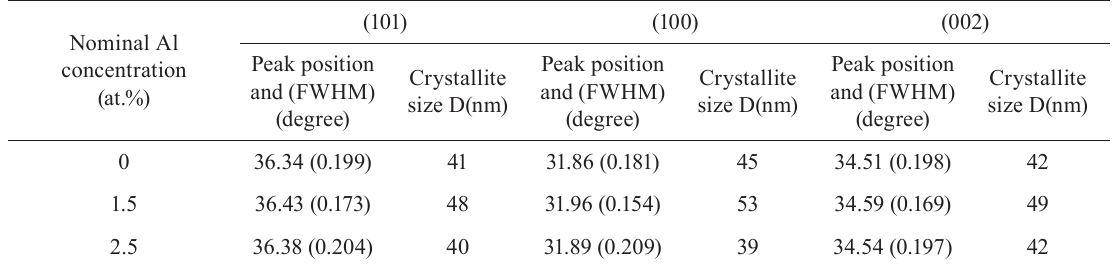
Table 2 Peak position, full width at half maximum (FWHM) and the estimated crystallite sizes from XRD data along